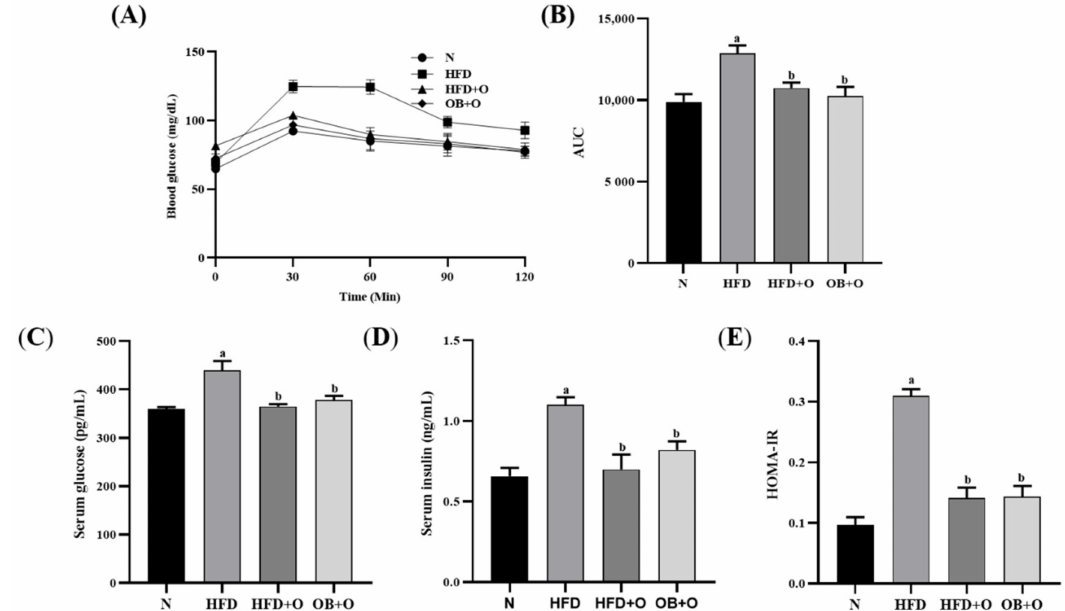
Figure 1. Insulin sensitivity in HFD-induced MAFLD rats. N, normal control; HFD, high-fat diet; HFD + O, high-fat diet + orlistat 10 mg/kg/day (protective model); OB + O, obese + orlistat 10 mg/kg/day (therapeutic model). ( A ) Oral glucose tolerance test (OGTT); ( B ) Area under the curve (AUC); ( C ) Serum glucose; ( D ) Serum insulin; ( E ) HOMA-IR. Data are expressed as mean ± SEM, n = 6/group. One-way ANOVA, followed by Tukey post-hoc test. a p < 0.05 vs. N group, b p < 0.05 vs. HFD